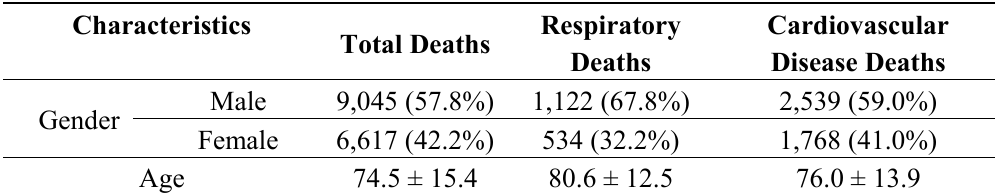
Table 1. Characteristics of the study